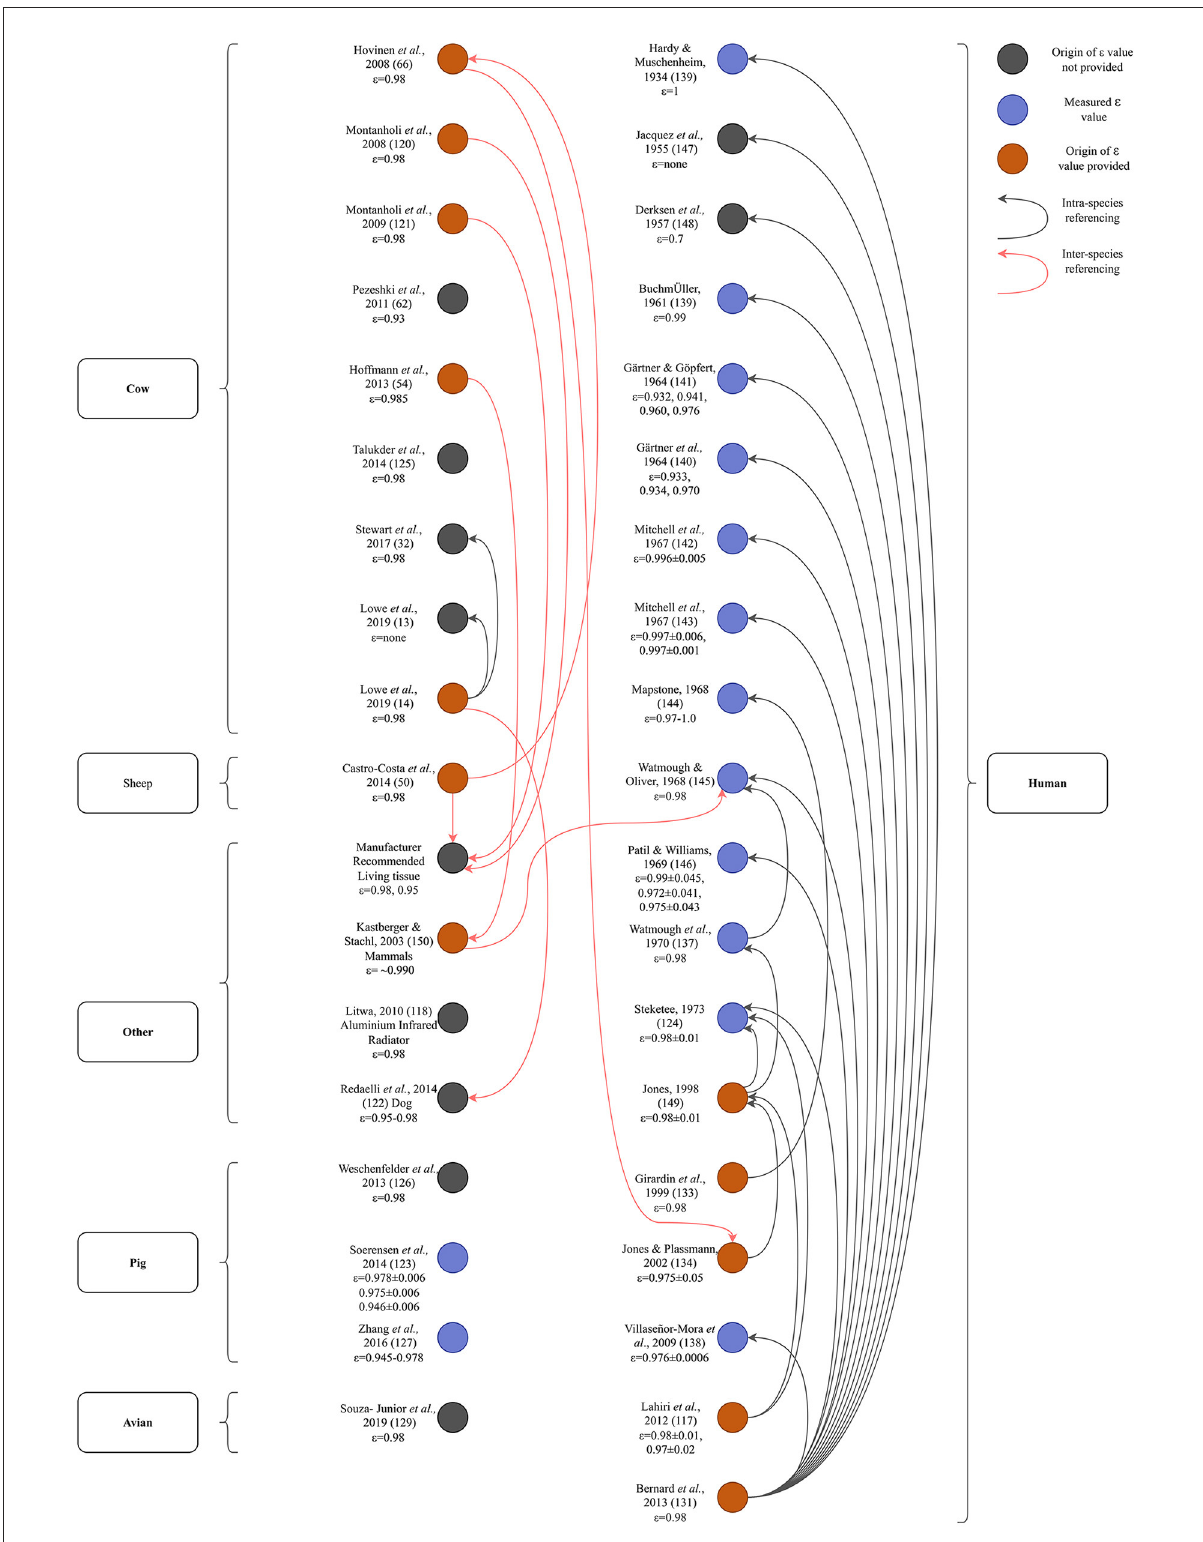
FIGURE5 Diagram illustrating the origins of emissivity values found in the studies included in the review. Out of 109 papers included in this review, 21 papers provided 27 sources for their emissivity value (20 original research articles, one review article, three books and three references to the camera’s manufacturer’s manual). These referenced sources and the sources which informed them are mapped out here to ascertain the